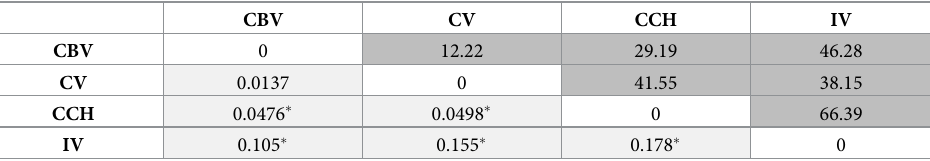
Below the diagonal, pairwise Fst comparisons between study sites. Significant genetic structure is shown as � p < 0.05. Linear Euclidian distances (km) between study sites are shown above the diagonal. Populations: CBV = Cerro Buena